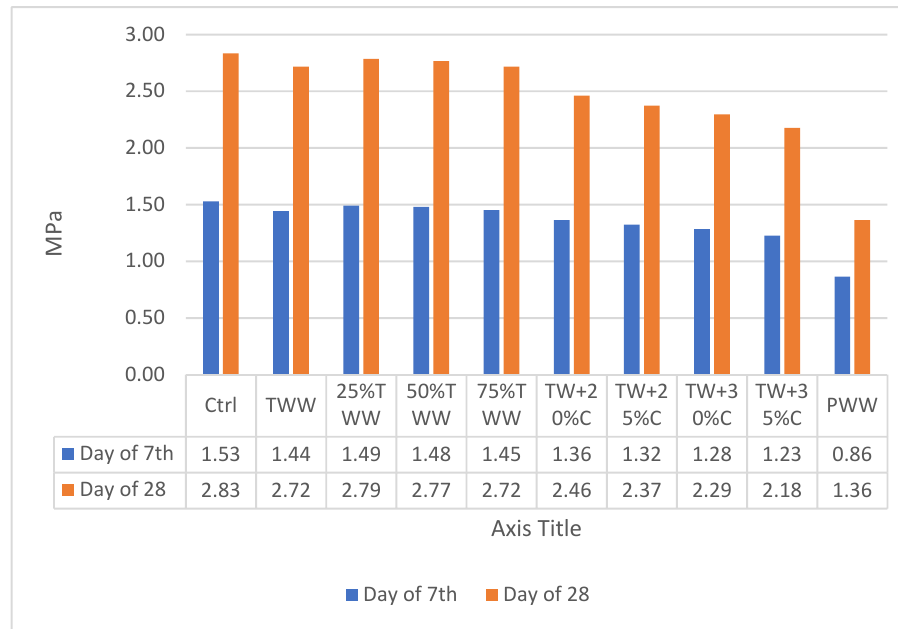
Figure 8. The results of tensile strength cured by drinkable water.